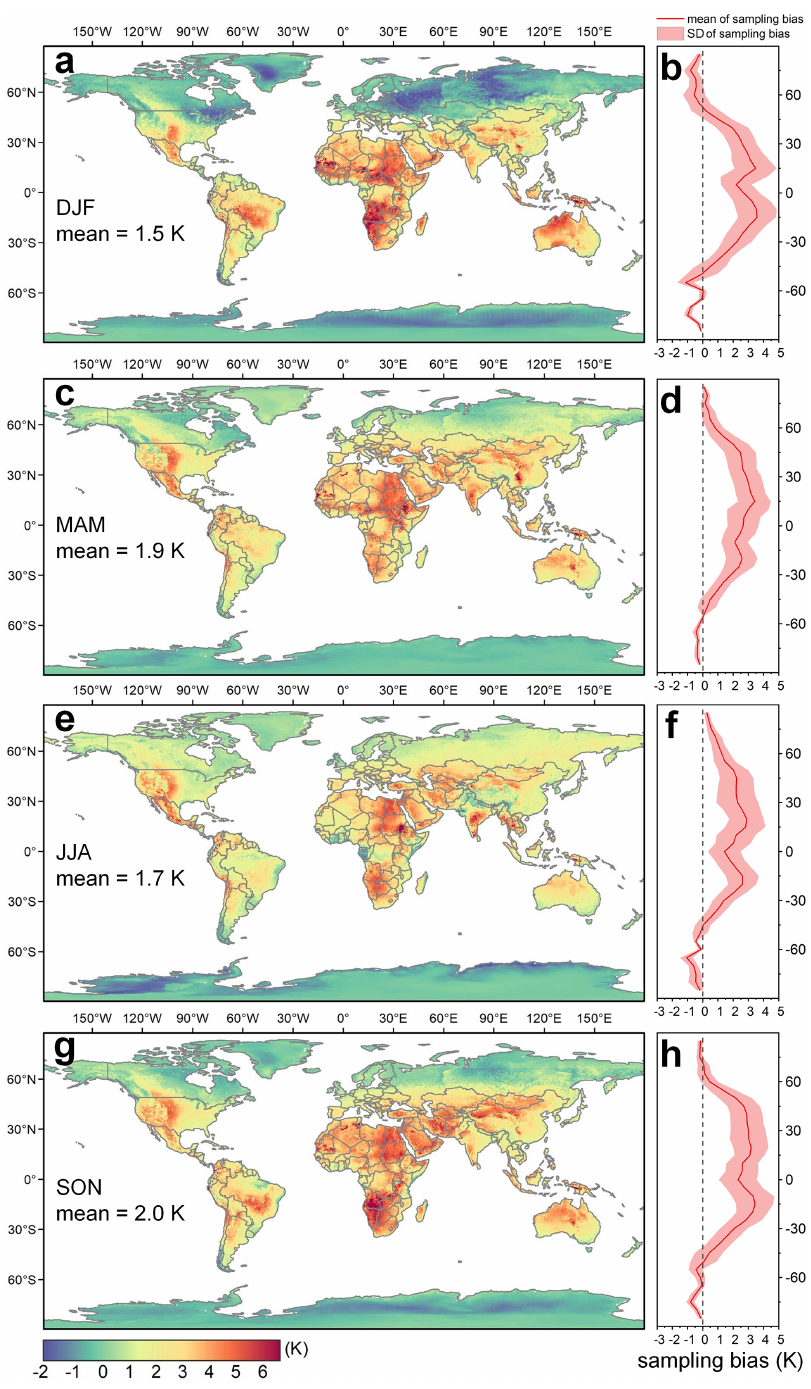
Figure C1. Average sampling bias (cid:49)T sb for indicated 3-month interval between 2003 and 2019. Panel (a) displays the (cid:49)T sb for December– January–February (DJF), and (b) displays the corresponding results averaged over 5 ◦ longitudinal intervals. Similarly, (c) and (d) , (e) and (f) , and (g) and (h) display the corresponding results for March–April–May (MAM), June–July–August (JJA), and September–October– November (SON),